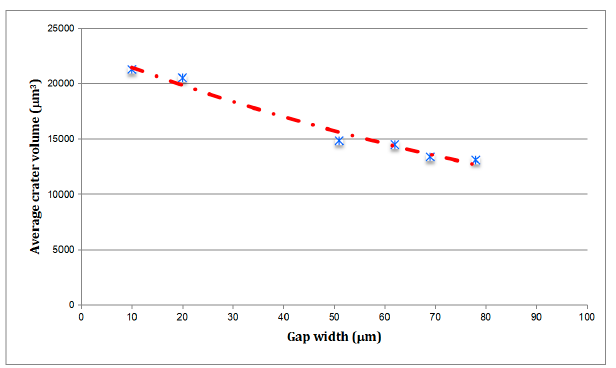
Figure 5. Average removal capacity per discharge vs. gap width (discharge surface roughness corresponding to roughing cut, R a 2.60 μ m, R t 15.27 μ m).